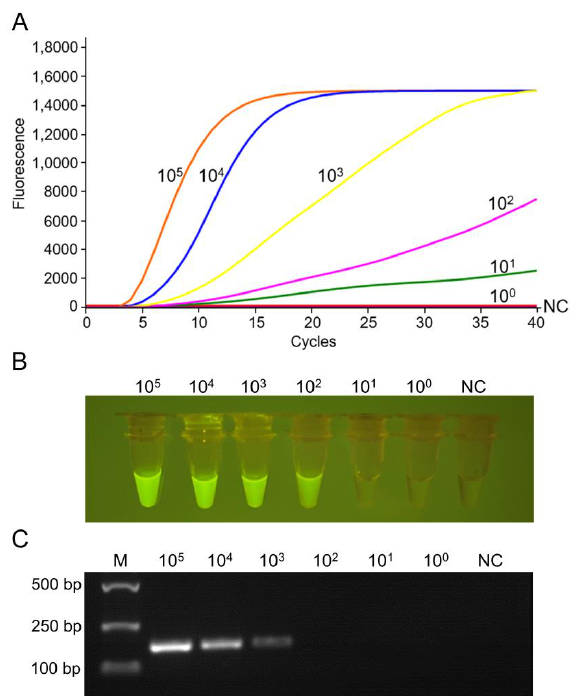
Figure 4. Sensitivity of RF-RT-RAA and RT-PCR for PRRSV-2 detection. ( A ) Sensitivity test of RF- RT-RAA through real-time fluorescence read-out. ( B ) Sensitivity test of RF-RT-RAA through visual observation. The image was captured by a mobile phone camera. ( C ) Sensitivity test of RT-PCR. NC, negative control.